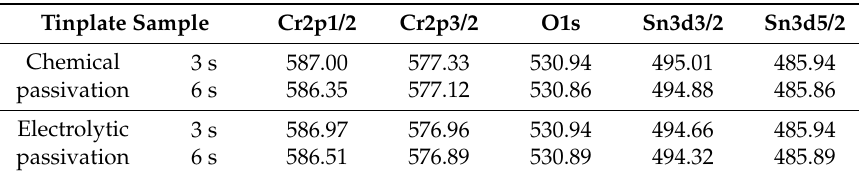
Table 5. Atomic percentage (at.%) of the elements on the tinplate surface treated with different passivation processes.